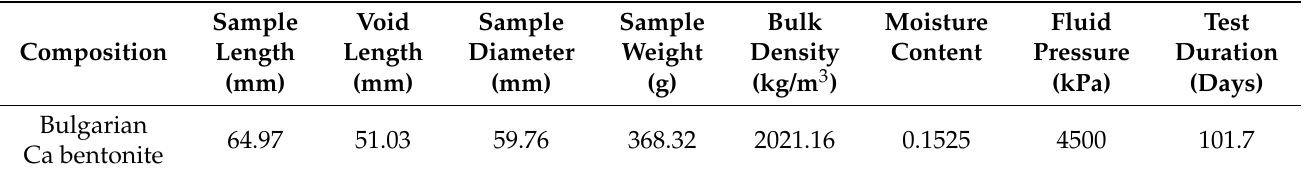
Table 1. Sample geotechnical parameters. The sample pre-test dimensions were measured using digital calipers and can be considered accurate to the nearest 0.1 mm. The sample weight is accurate to the nearest 0.01 g.